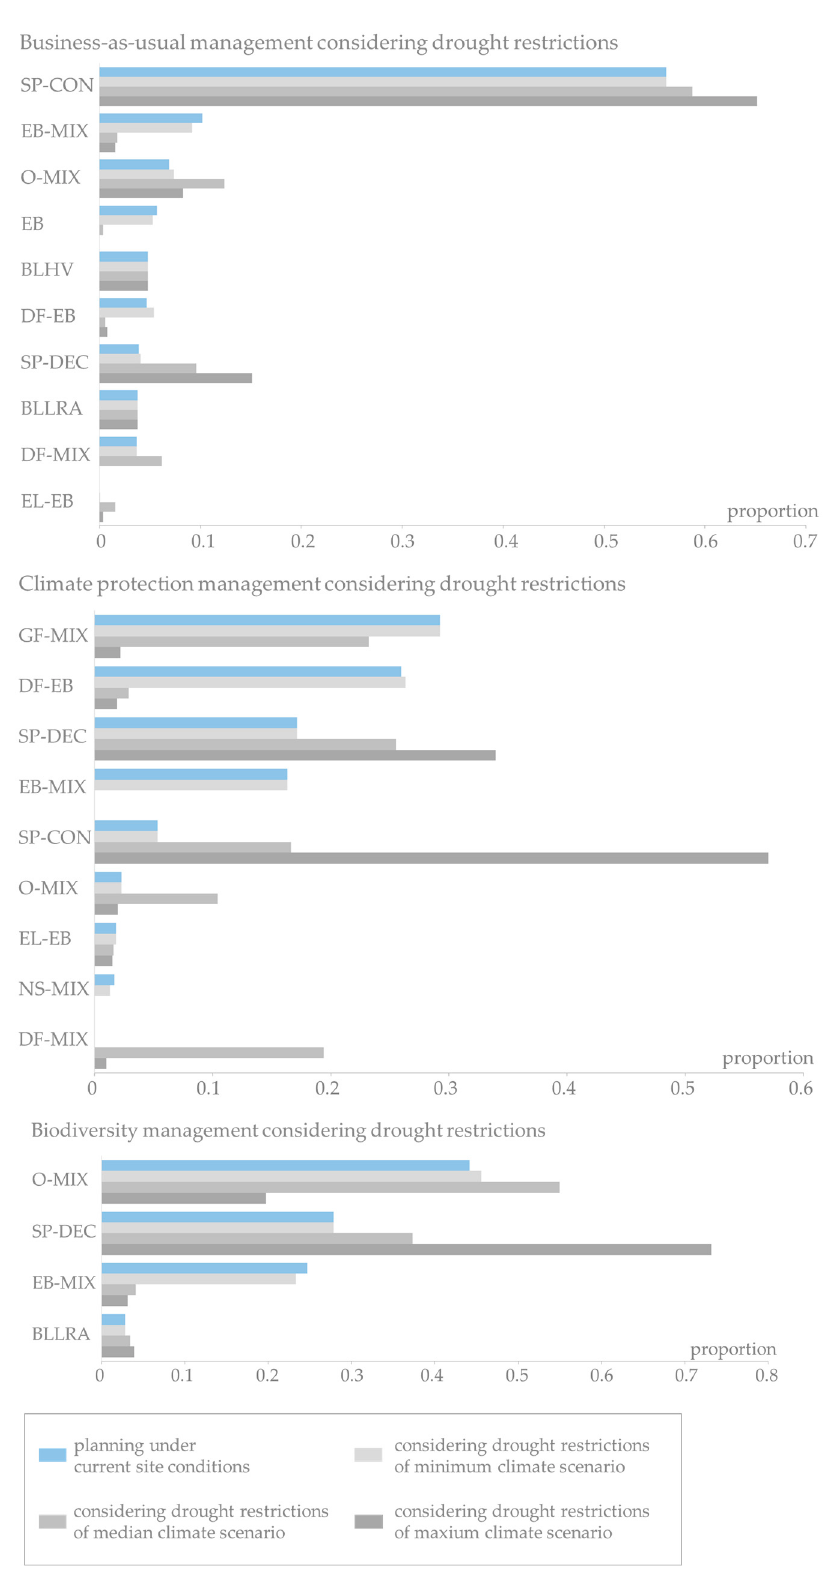
Figure 6. Frequency distribution of succeeding stand type area under constant site conditions in 2070 ( light blue ) and adaptive planning (stage 2) considering drought restrictions under minimum ( light gray ), median ( gray ) and maximum ( dark gray ) climate scenarios under three silvicultural management strategies in Uelzen.